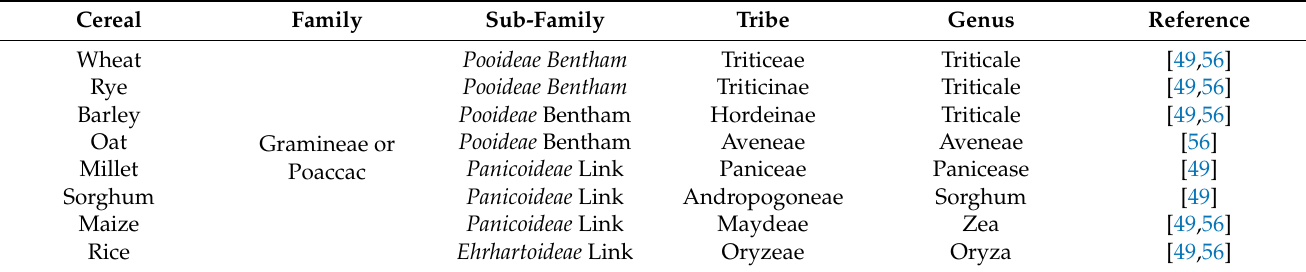
Table 3. Major assortments of cereals-specific